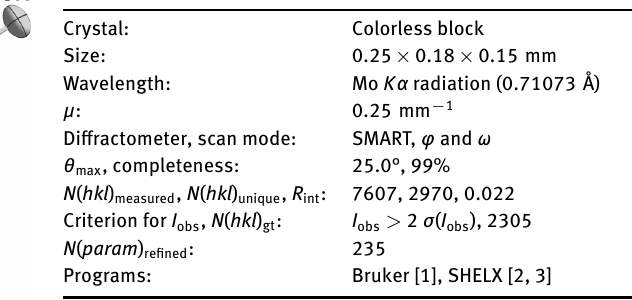
Table 1: Data collection and handling.